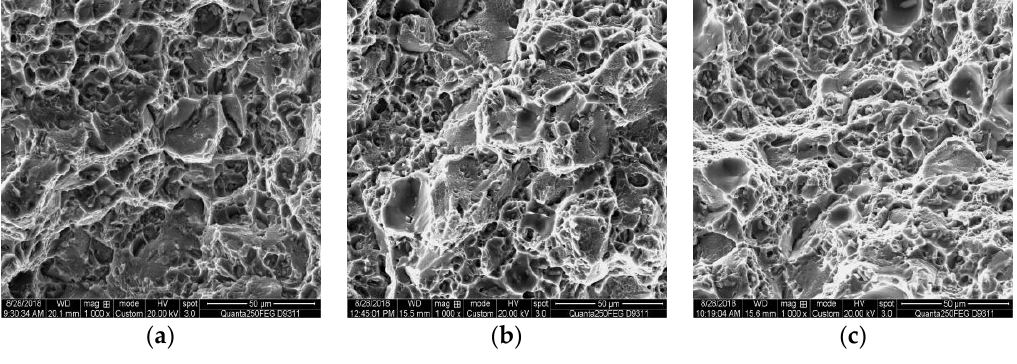
Figure 11. High-temperature fracture properties of T6 ZCL205A alloy deposit manufactured with the different deposition processes. ( a ) A fracture morphology image showing a sample prepared using the CMT process; ( b ) a fracture morphology image showing a sample prepared using CMT and Pulse process; and ( c ) a fracture morphology image showing a sample prepared using the CMT Pulse and Advanced process.